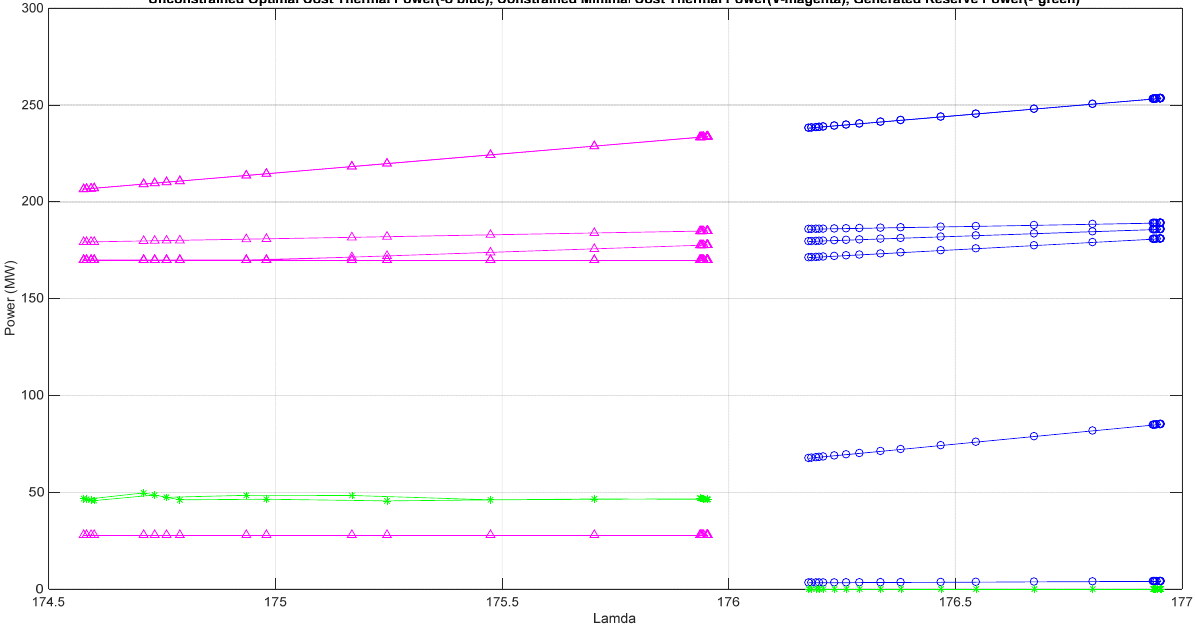
Figure 4. Convergence from unconstrained optimal cost to constrained optimal cost for the thermal units Th1–Th7 from northwest Greece over 24 h. The unconstrained minimal cost powers (blue o), the constrained minimal cost powers (magenta ∇ ), and the generated reserves of power (green*) are shown versus λ . Over 24 h, small displacements of unconstrained optimal λ , are varying from λ 1 = 176.95 to λ 1 = 176.18, and of constrained optimal λ are varying from λ = 175.95 to λ = 174.71.